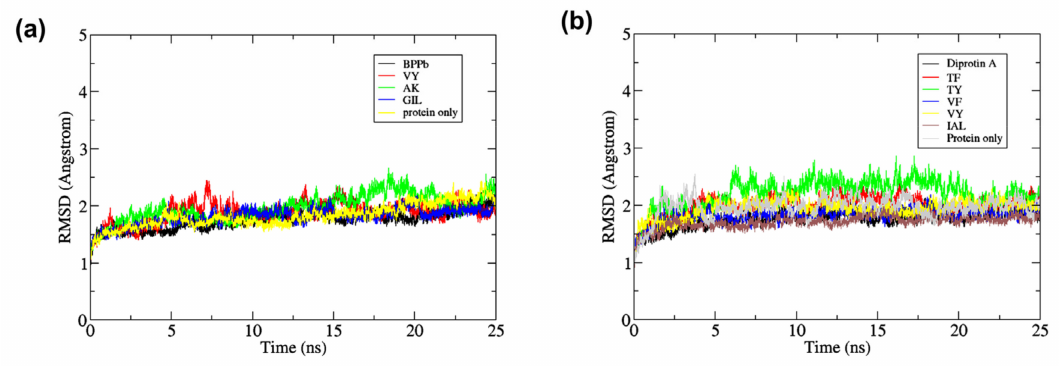
Figure 2. All-atom root mean square deviation (RMSD) of ( a ) Free ACE and ACE-peptide complexes ( b ) Free DPP-IV and DPP-IV-peptide complexes during 25 ns of the molecular dynamics simulation. Similarly, the RMSD analysis for anti DPP-IV and peptide complexes was also con- ducted. Here, the inhibitory peptide candidates TF, TY, VF, VY, and IAL which form complexes with DPP-IV, and DPP-IV- diprotin A complex were subjected to 25 ns MD simulation. The all-atom protein mean RMSD value for DPP-IV-diprotin A complex was lower (1.76 ± 0.15 Å) compared to all dipeptides subjected in the study (TF = 2.00 ± 0.15 Å, TY = 2.20 ± 0.25 Å, VF = 1.82 ± 0.12 Å, VY = 1.93 ± 0.15 Å). However, the tripeptide IAL (1.71 ± 0.11 Å) showed a considerably low mean RMSD value against Diprotin A,